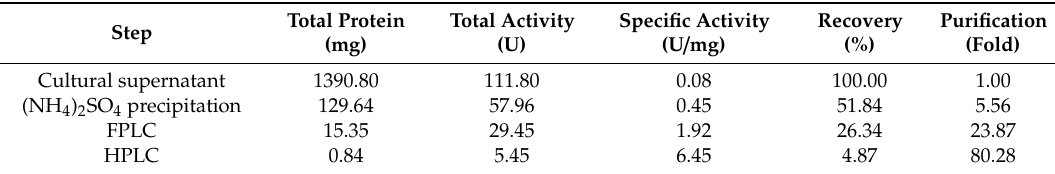
Table 1. Purification of Paenibacillus sp. TKU047